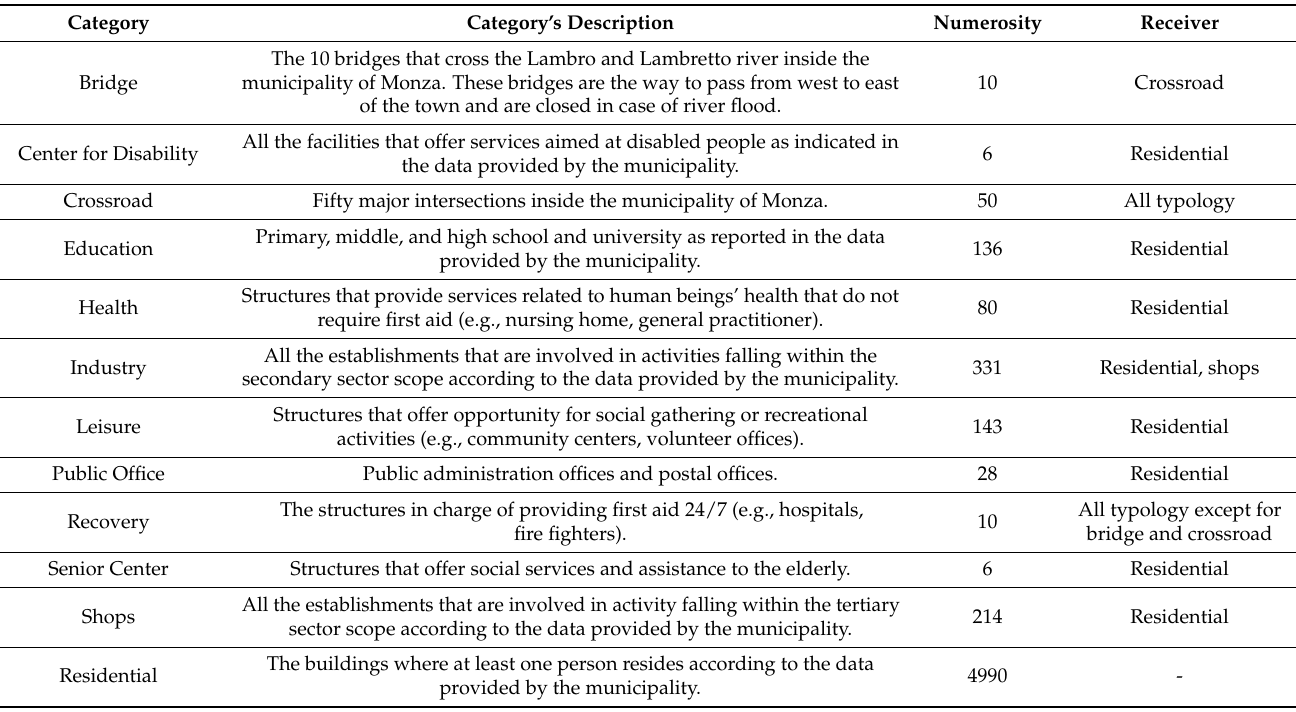
Table 2. List of node